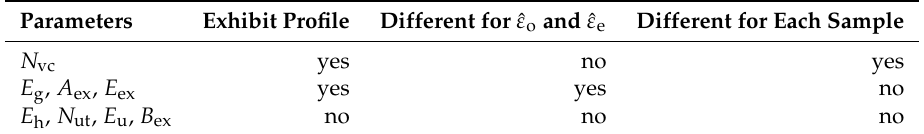
Table 1. Summary of dispersion